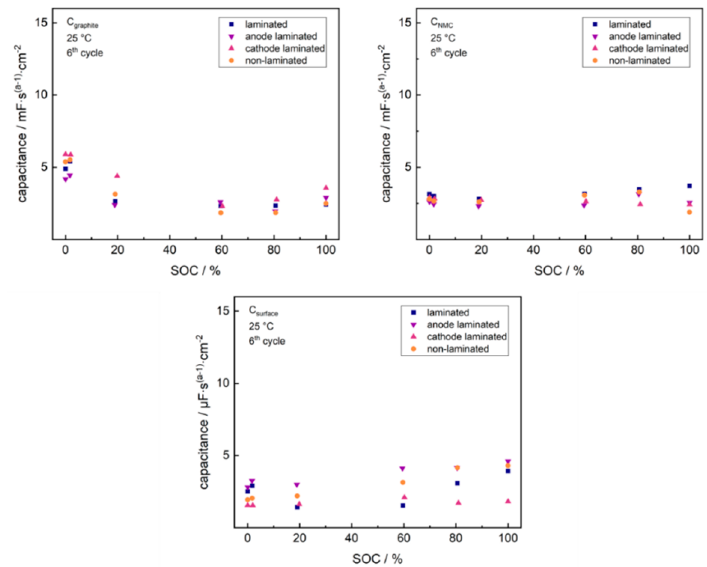
Figure 3. EIS capacitance fit parameters of laminated / partially laminated / non-laminated cells along charging step, sixth cycle; data normalized to geometric electrode area.